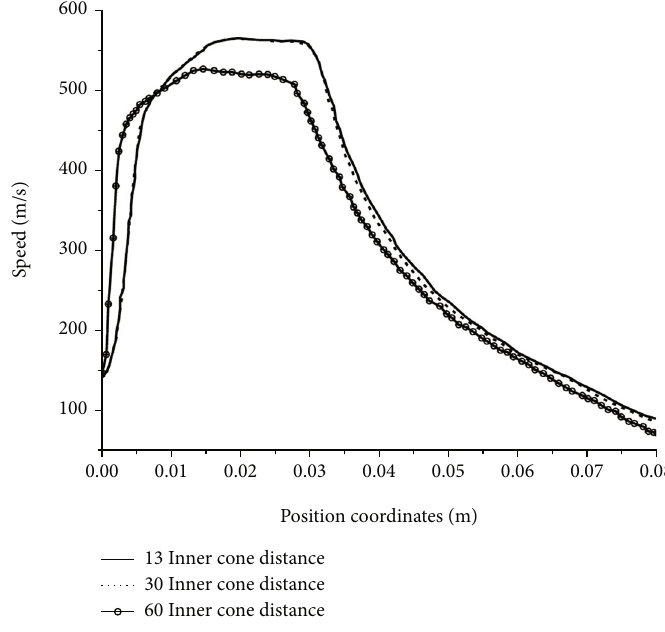
Figure 6: Velocity distribution of the water jet on the central